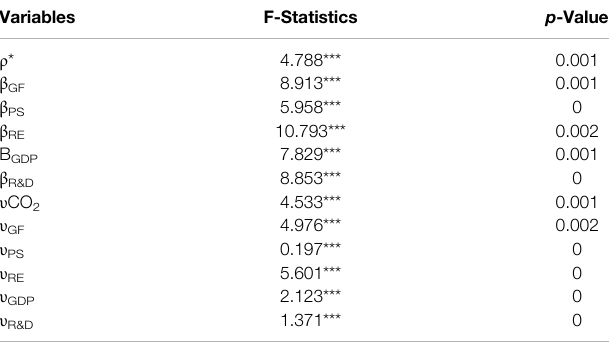
TABLE 6 | Results of the Wald test for the constancy of parameters.